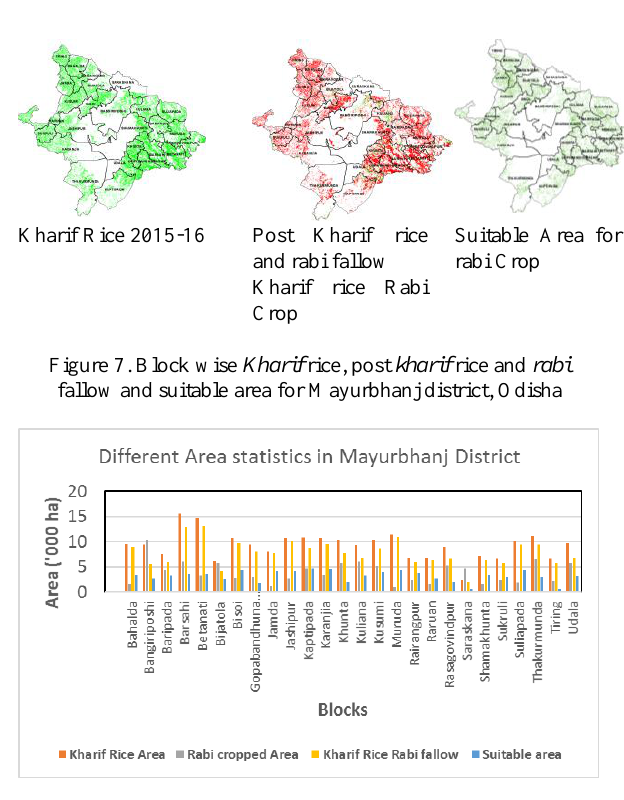
Figure 8: Block level Statistics of Mayurbhanj district of Odisha 4.4 Site suitability analysis for Balasore (Odisha)